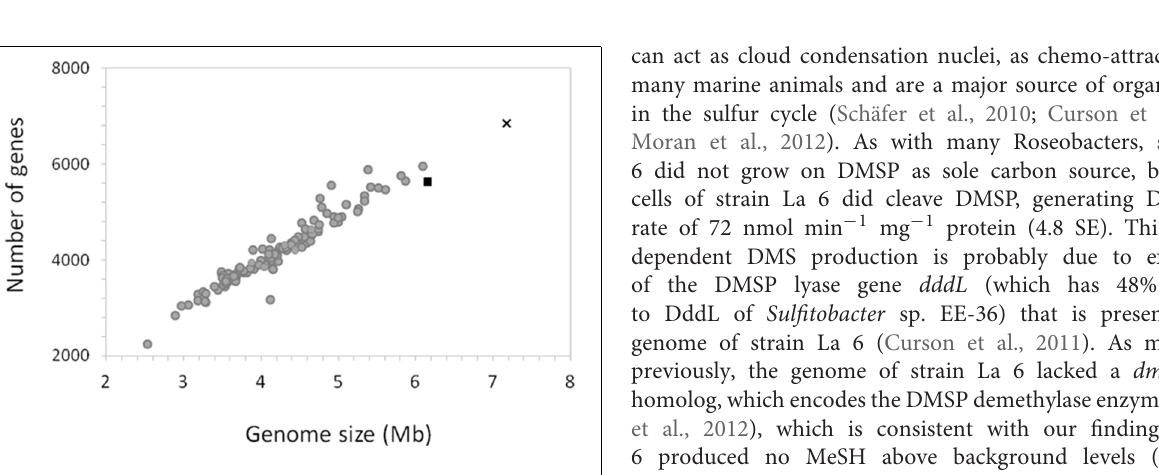
FIGURE 5 | Relationship between genome size and number of genes in the genome of strain La 6 compared to the genomes of 114 members of the Roseobacter group. The genome of strain La 6 is represented by the black cross, the black triangle is the closest relative at the 16S rRNA gene sequence, Marinibacterium profundimaris strain 22II1-22F33 T and gray circles depict all other members of the Roseobacter